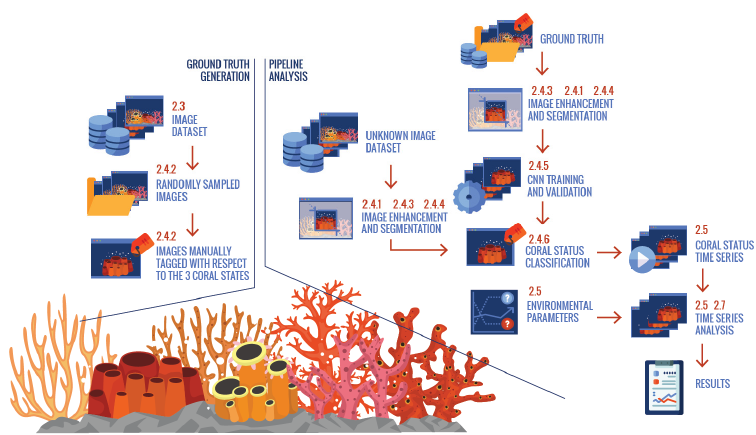
Figure 2. Pipeline for biological data extraction (via automated video-imaging procedures, based on Convolutional Neural Network (CNN) groundthruted routines) and analysis (via multivariate time-series treatment) of high relevance for advanced ecological monitoring functionalities by cabled observatories. Numbers on the upper right corner of each box (i.e., the treatment pipeline step) are referring to the numerals for the respective Materials and Methods section of this paper.